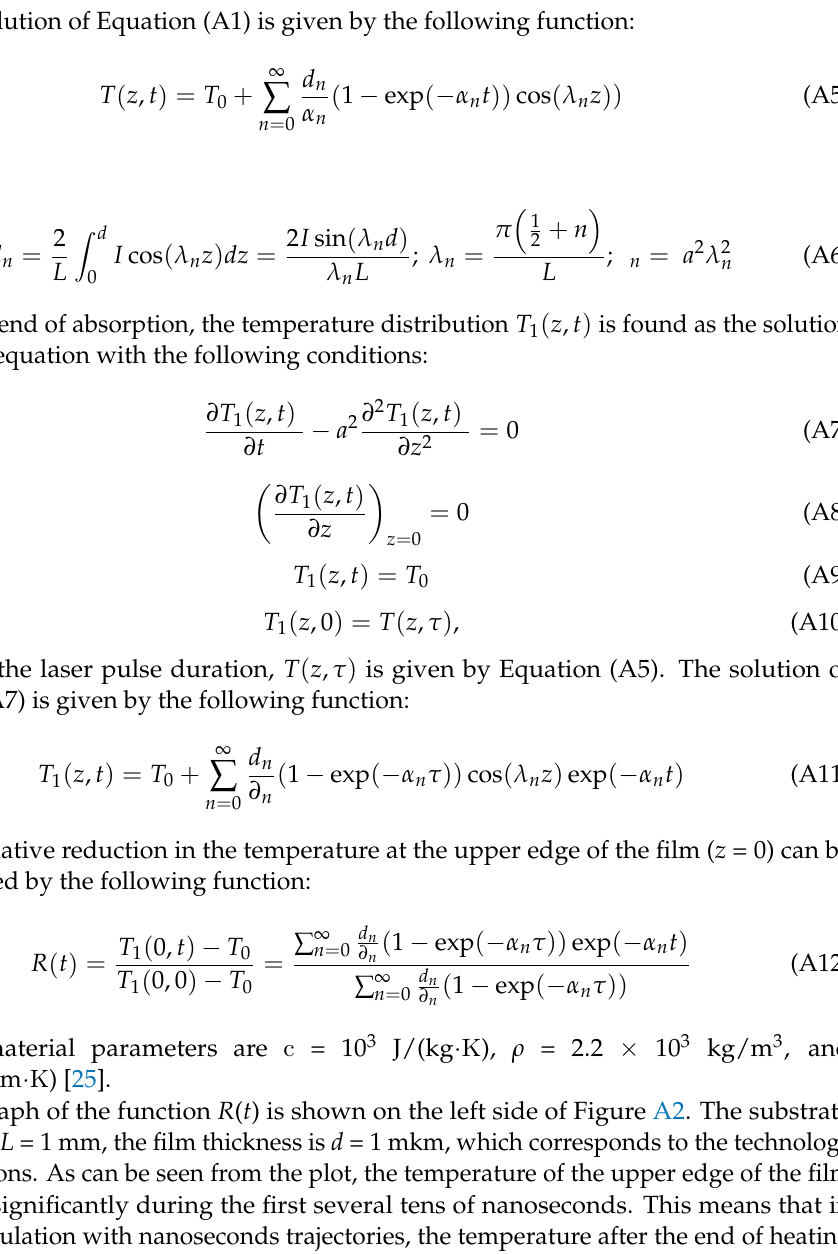
Figure A1. Function, describing the energy